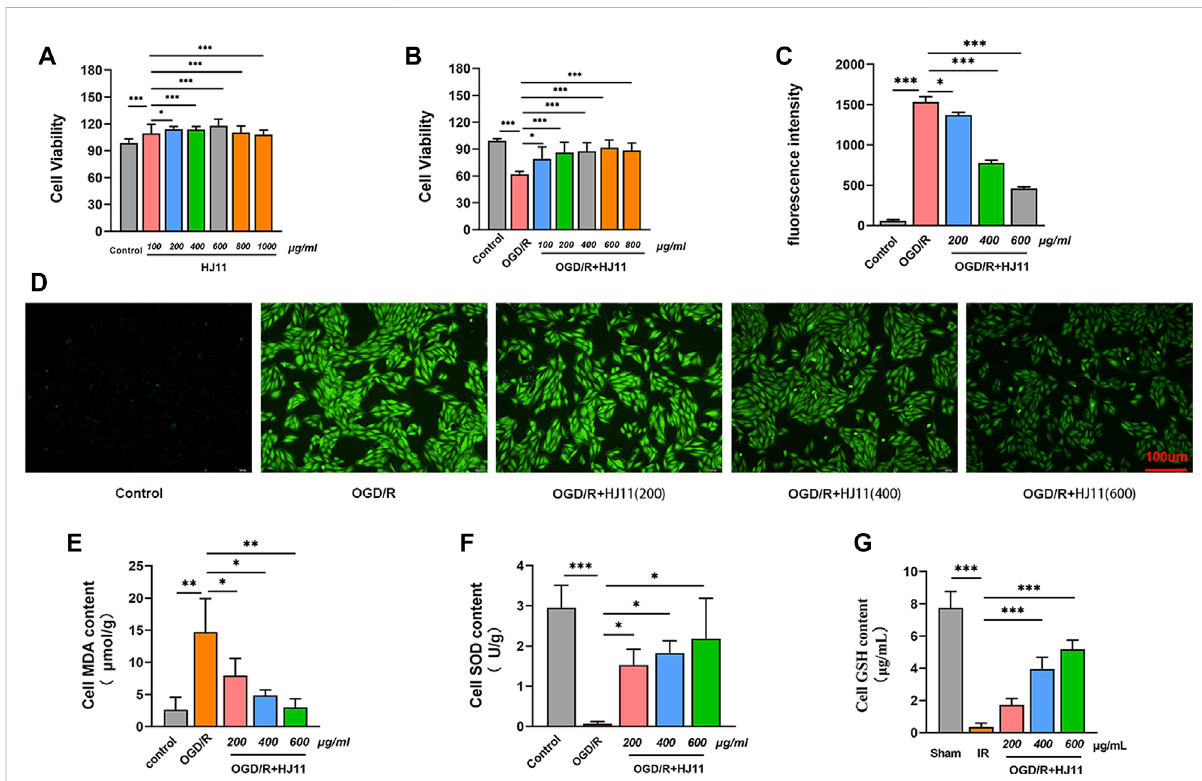
Effects of HJ11 decoction on OGD/R-triggered injury in H9c2 cells. (A,B) Cytotoxicity assay with HJ11 decoction application to normal H9c2 cells and oxygen-glucose deprivation-reperfusion (OGD/R) – induced H9c2 cells suggesting that HJ11 decoction was nontoxic to normal H9c2 cells at doses of 100 – 1000 μ g/ml and to OGD/R-induced H9c2 cells at doses of 100 – 800 μ g/ml. (C,D) Dichloro-dihydro- fl uorescein diacetate staining and statistical analysis showing that HJ11 decoction reduced the level of reactive oxygen species in OGD/R-induced H9c2 cells. Scale bar: 100 µm. (E – G) HJ11 decoction reduced the level of malondialdehyde but elevated the levels of superoxide dismutase and glutathione in the OGD/R-induced H9c2 cells. * p < 0.05. ** p < 0.01. *** p < 0.001. Data are shown as mean ± standard deviation. N = 3 – 4 for